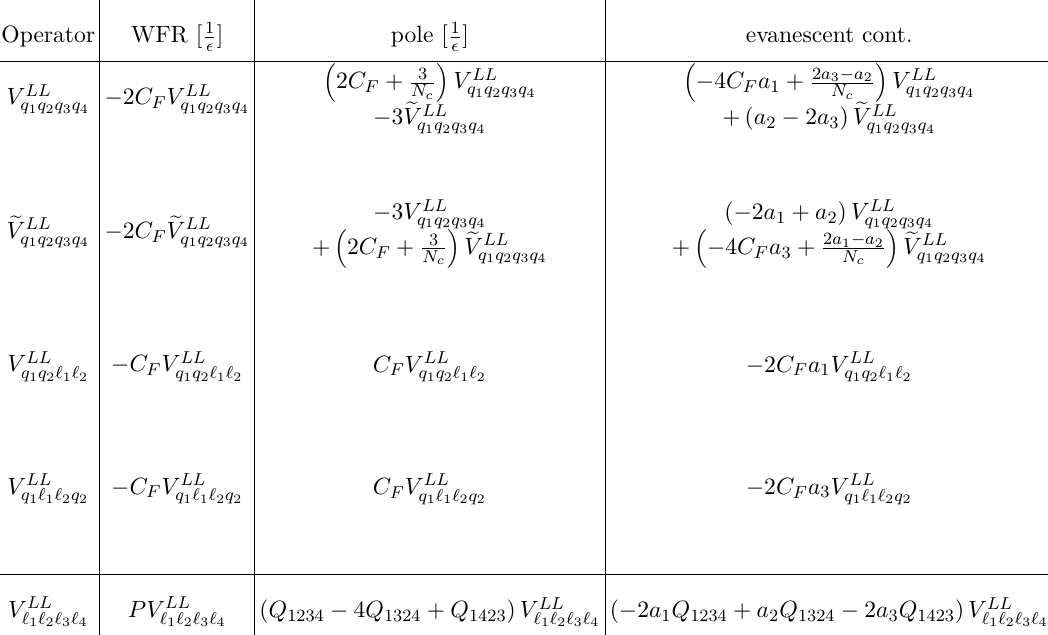
Table 11. Loop structure for γ µ P L ⊗ γ µ P L operators: the columns correspond to the divergent WFR contributions and vertex corrections as well as the finite contributions from evanescent op- erators, computed in the generalised BMU scheme. The first four rows result from QCD and are given in units of α s / (4 π ) whereas the last one is a QED correction given in units of α/ (4 π )